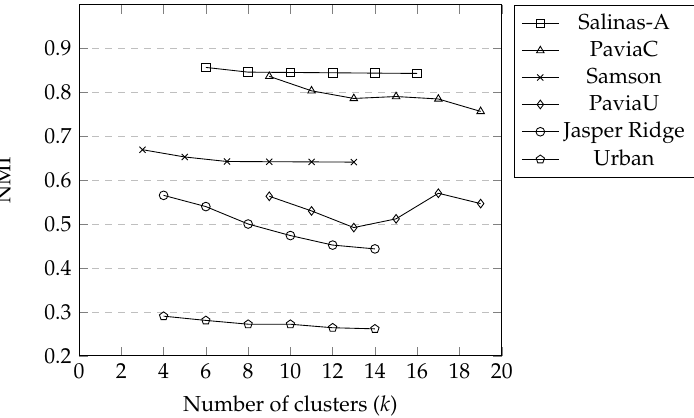
Figure 6. NMI values that were obtained at different number of clusters for the proposed method.